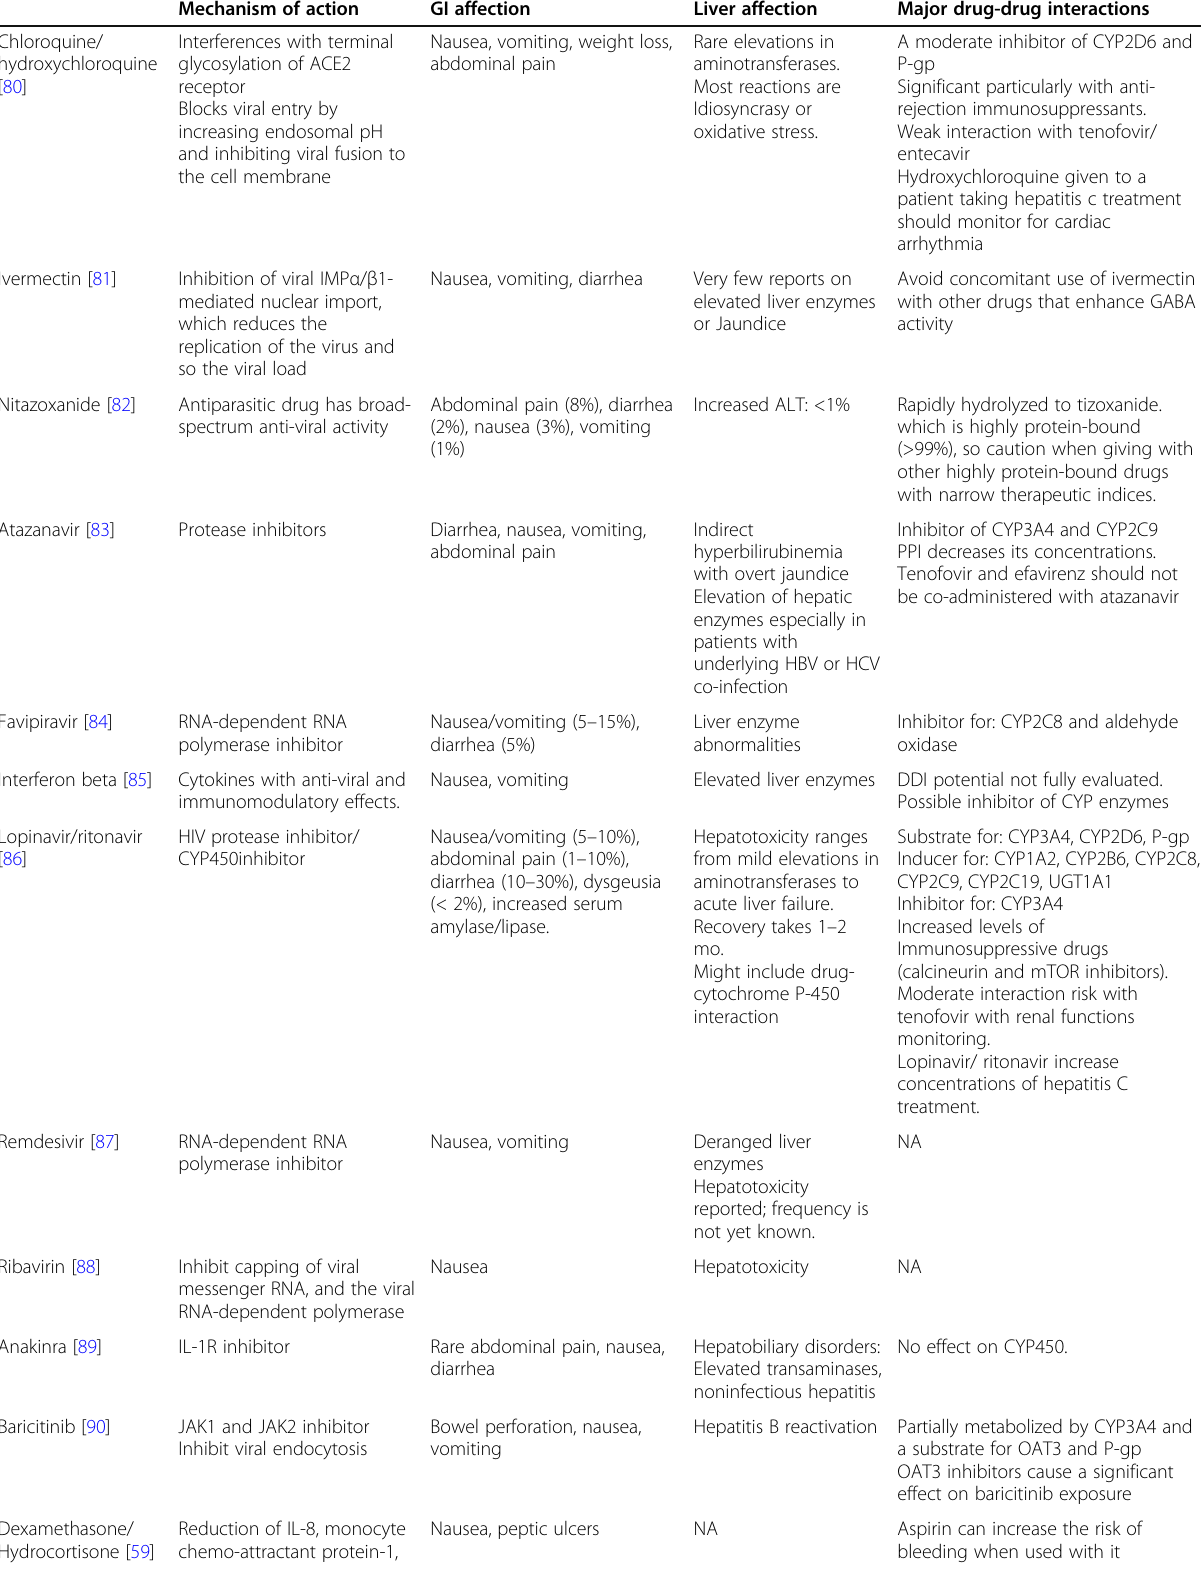
Table 1 Potential GI and liver adverse effects and drug interaction profile of COVID-19 investigational